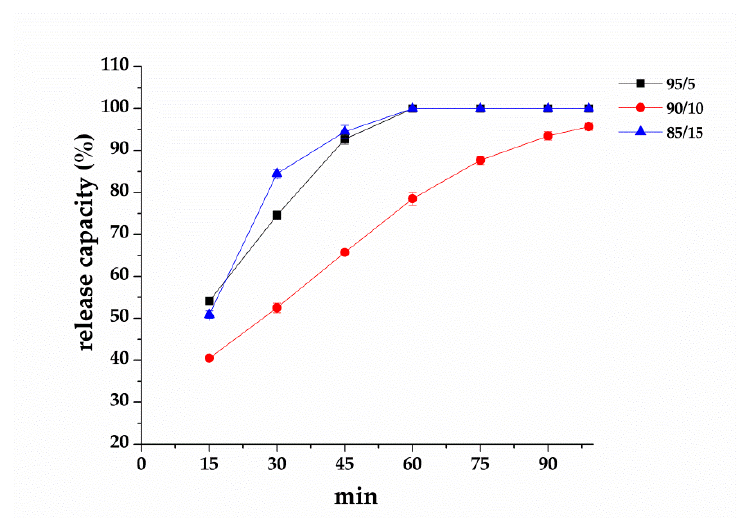
Figure 7. The release capacity (%) of nanofibrous membranes as related to the PVA/EGO ratio.